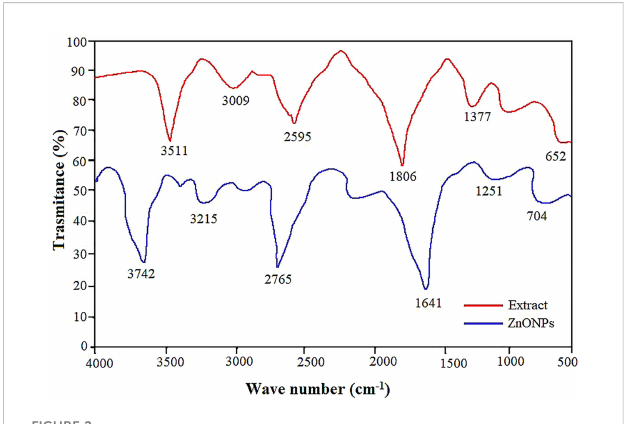
FIGURE 2 Comparison of the FTIR spectra of the pecan leaf extract and ZnO NPs. Each peak in the ZnO NPs indicates the functional group of the phytochemical involved in nanoparticle synthesis.